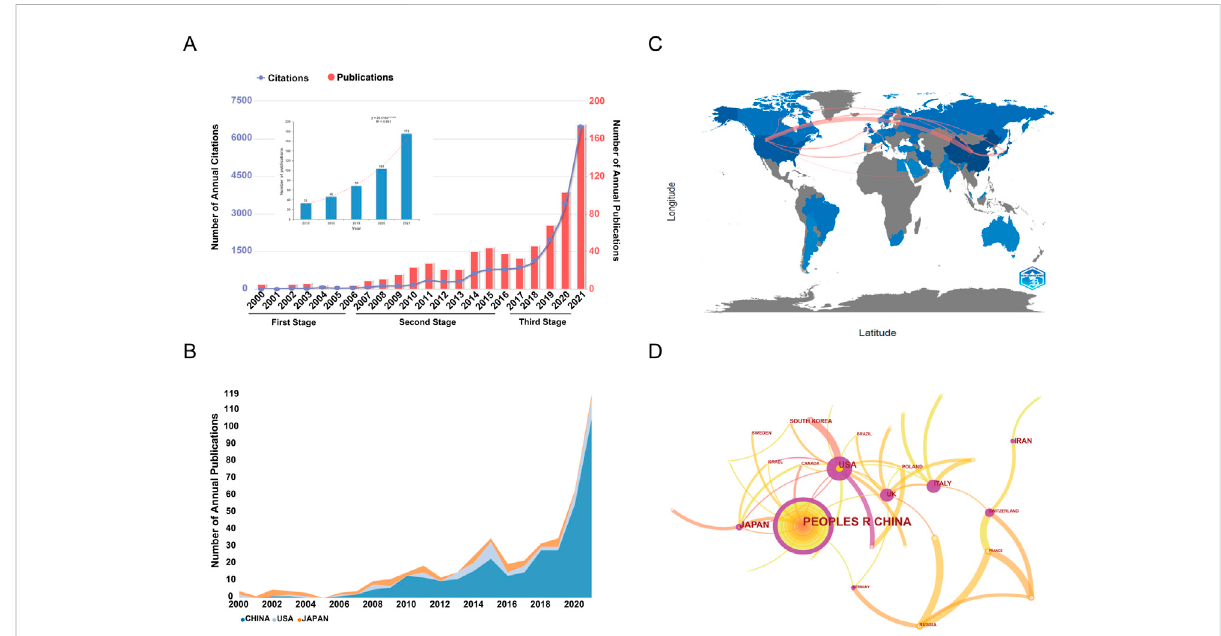
FIGURE 2 (A) Annual publication and citation trendsof literature related to SDT. (B) Annual publication trend among thetop three countries from 2000to 2021. (C) Cooperation analysis of countries/regions involved in SDT research. (D) The countries/region ’ s co-authorship overlay visualization map generated by using VOSviewer. The nodes in the graph represented countries/regions, and lines between the nodes re fl ected the co-authorship relationships.Nodes weremarkedwith differentcolors according to theiraverageappearingyear (AAY). Thesize ofthenodeswasproportional to the number of